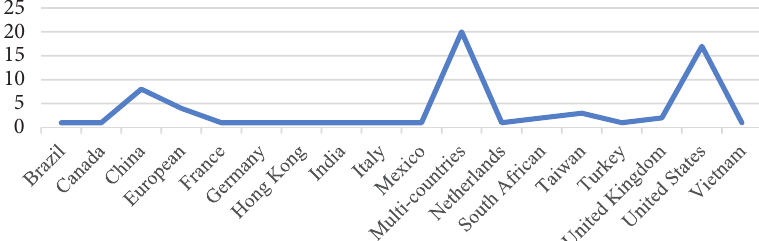
Figure 2. Countries studied and number of articles on